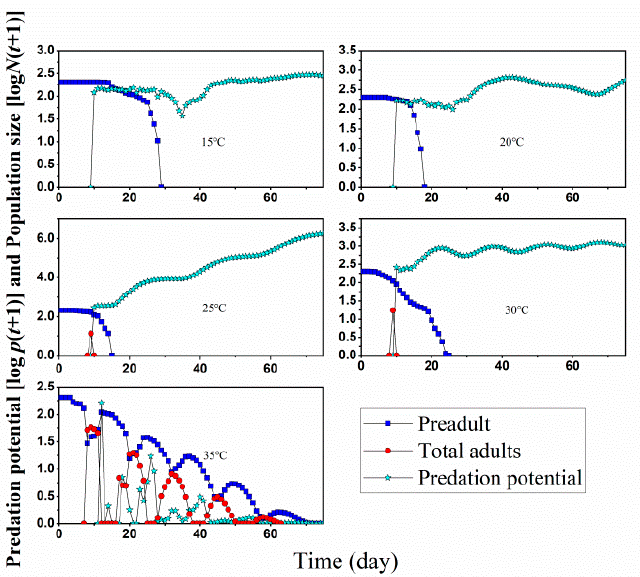
Figure 7. Simulated population growth of D. minowai starting form 200 eggs with five pairs of adults O. minutus released on the tenth day. Predation potential is the predation ability of O. minutus to D. minowai at time t .